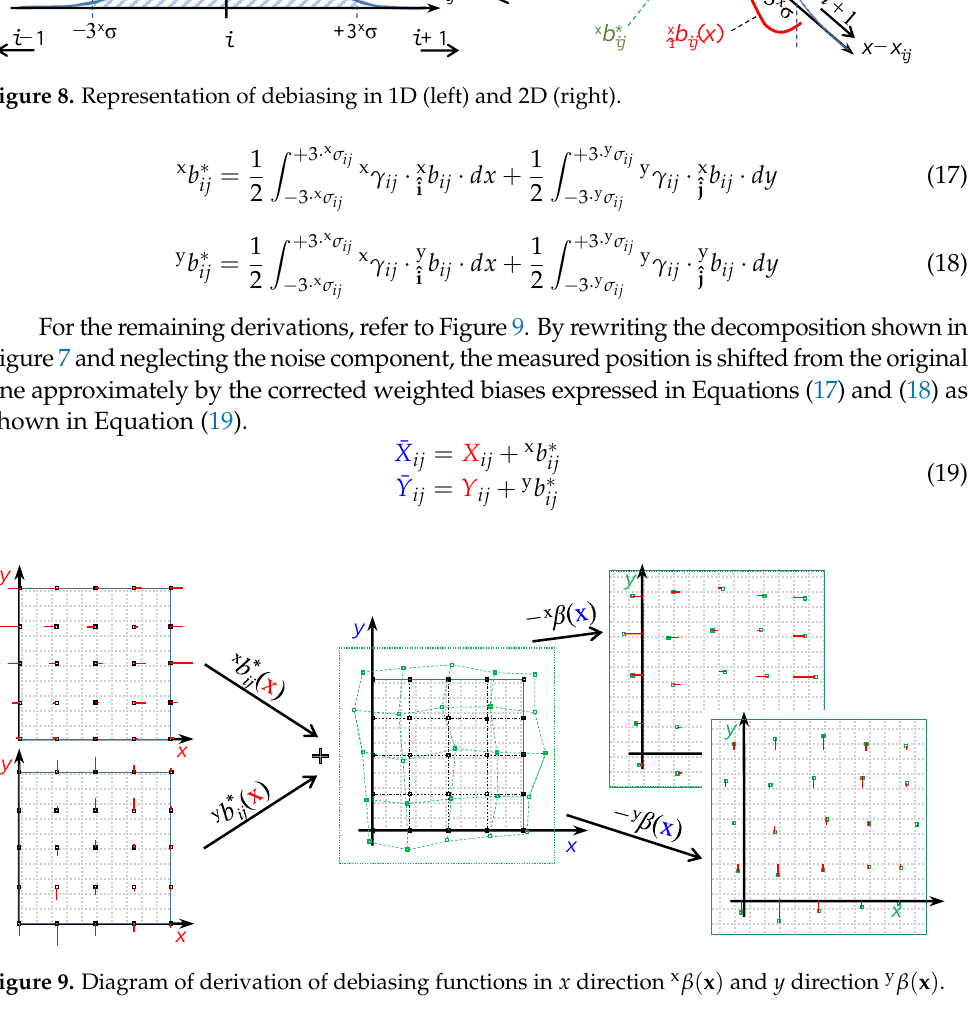
deformed grid [ ¯ x i , j ¯ y i , j ] . As shown in Equation (20), the two new corrected bias